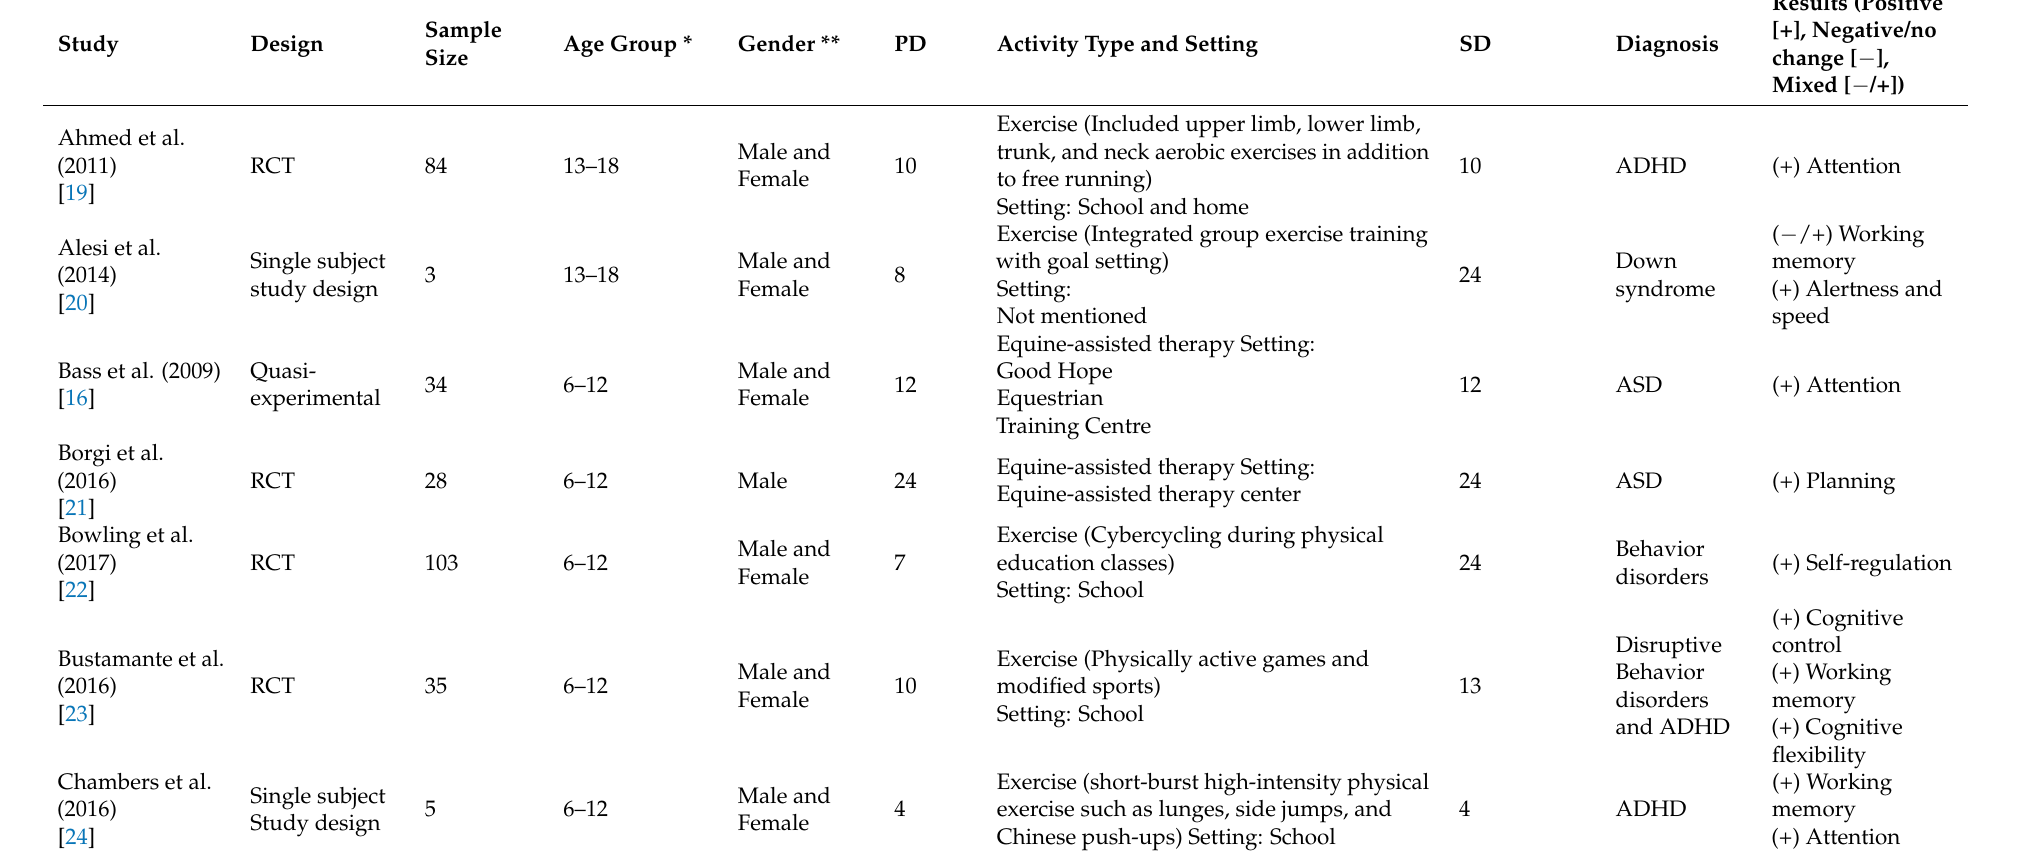
Table 1. Summary of study